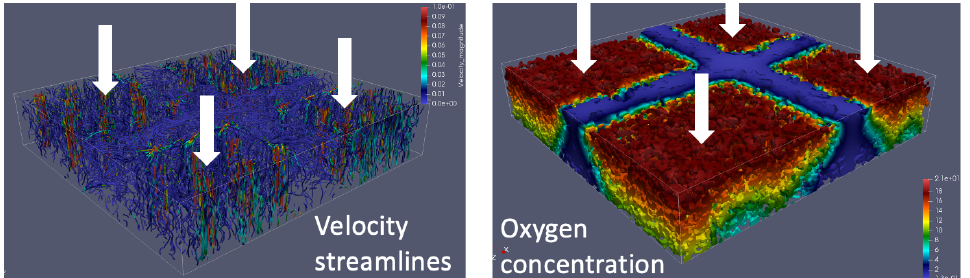
Figure 16. Velocity streamlines colored by velocity magnitude ( left ), and oxygen concentration ( right ) in the poroelastic gel. The direction of flow is from top to bottom. The red streamlines in the figure on the right indicate where the ultrafiltrate channels are located.